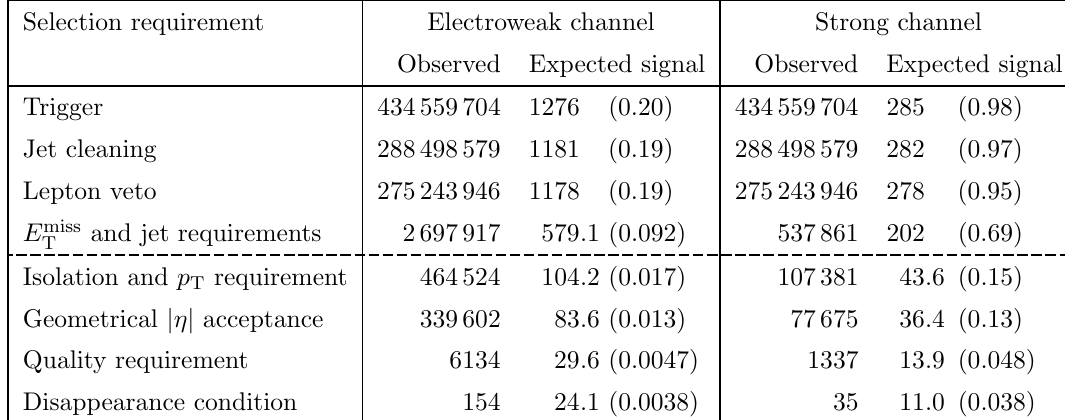
Table 1 . Summary of the selection criteria, and the corresponding observed number of events in data as well as the expected number of signal events in simulation for two benchmark models: a chargino produced in direct electroweak production with ( m chargino produced in the strong channel with ( m ~ g ; m high- E miss region. The expected number of signal events is normalised to 36.1 fb (cid:0) 1 . The signal T selection e(cid:14)ciencies are also shown in parentheses. The (cid:12)rst row shows the number of events after the application of detector and data quality conditions. Requirements below the dashed line are applied to tracks and